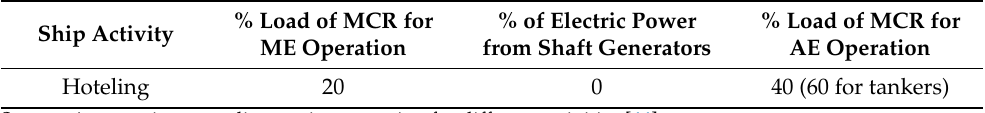
% Load of MCR for ME Operation